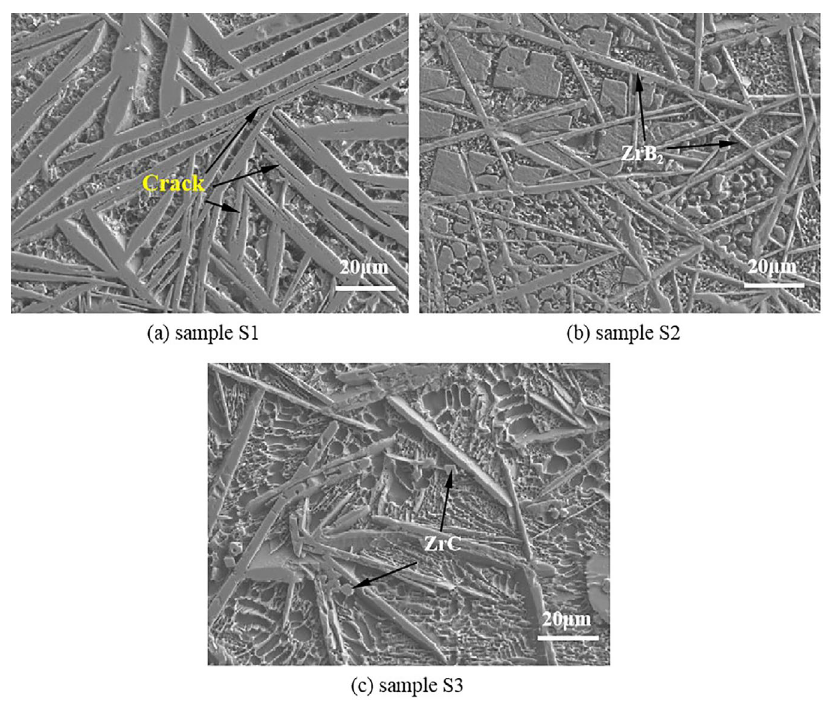
Figure 4. EPMA micrographs of the middle zone of the coatings: (a)sample S1; (b)sample S2; (c)sample